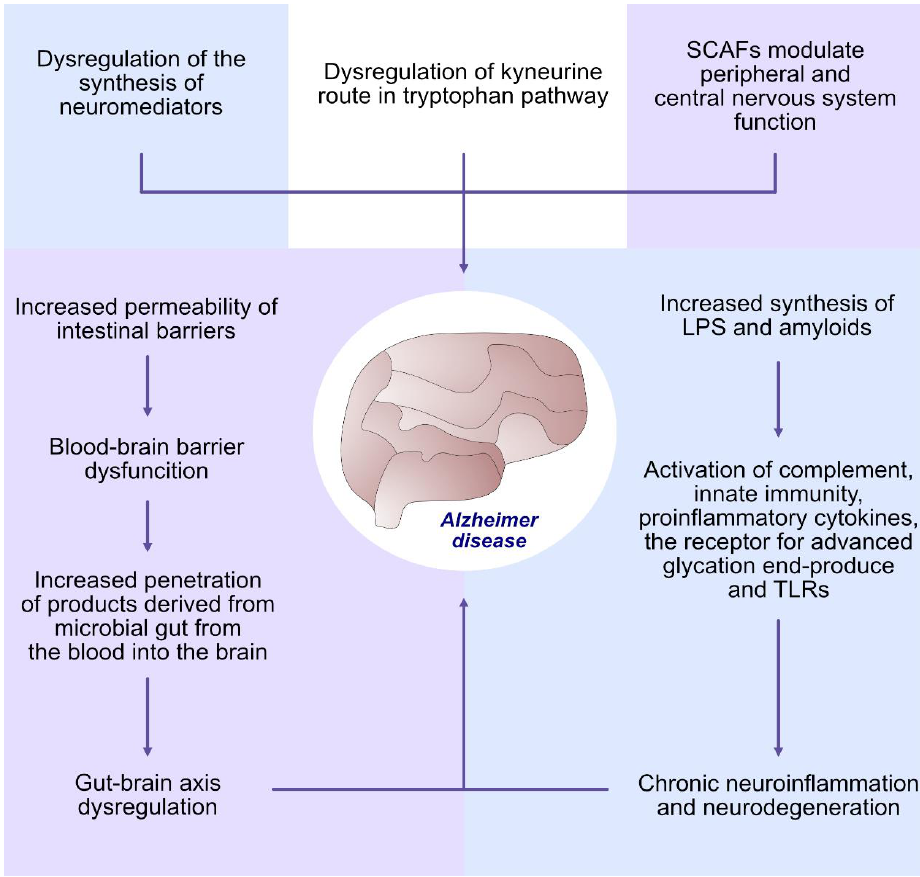
Figure 1. The involvement of oral microbiome dysbiosis in the development of Alzheimer’s disease. SCFAs — short-chain fatty acids, TLRs — toll-like receptors, LPS — lipopolysaccharide.